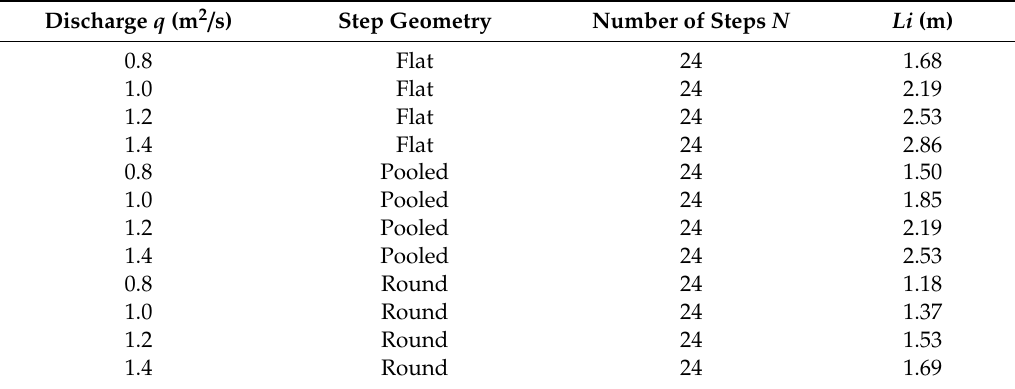
Figure 8. Water volume fraction contours of round, pooled, and flat stepped spillway models in the central plane with same number of steps N = 24 at unit discharge 0.8 m 2 / s and 1.0 m 2 / s ( a ) flat stepped spillway (N = 24) at unit discharge 0.8 m 2 / s; ( b ) pooled stepped spillway ( N = 24) at unit discharge 0.8 m 2 / s; ( c ) round stepped spillway ( N = 24) at unit discharge 0.8 m 2 / s; ( d ) flat stepped spillway ( N = 24) at discharge 1.0 m 2 / s; ( e ) pooled stepped spillway ( N = 24) at unit discharge 1 m 2 / s; and ( f ) round stepped spillway ( N = 24) at unit discharge 1 m 2 / s. Table 3. Summary of unit discharge ( q ), step geometry, and inception point ( Li